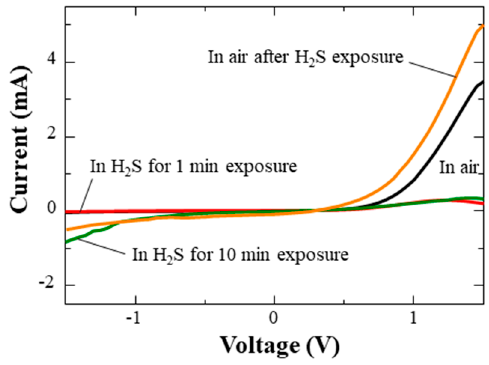
Figure 3. IV curves of the CuO NCs/ZnO NRs device in air and air containing 8 ppm H 2 S at 150